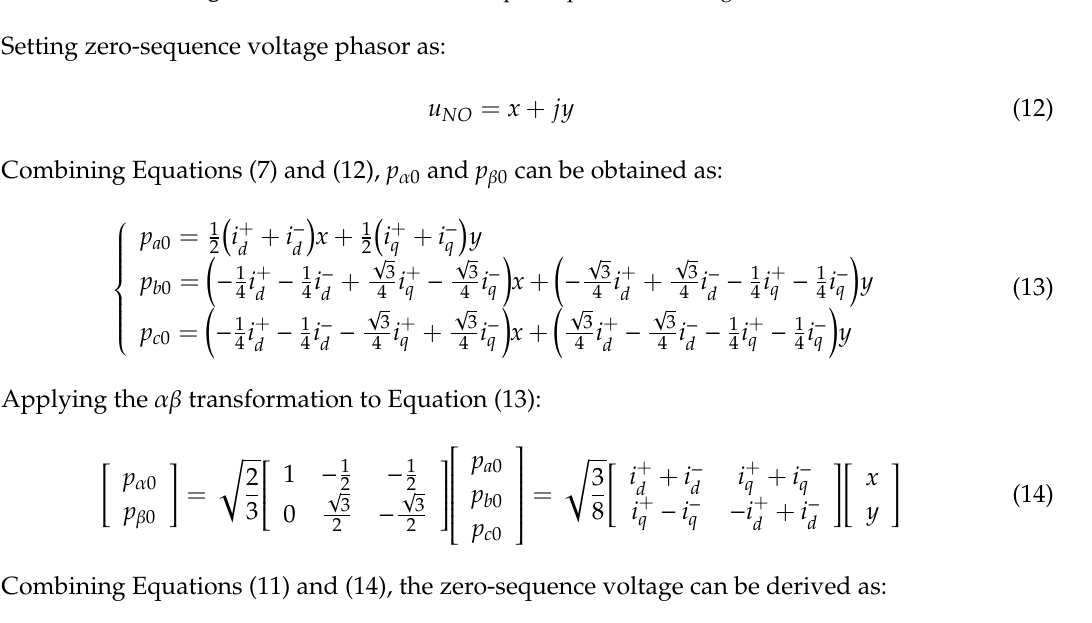
Figure 3. Control block of inter-phase power balancing control.